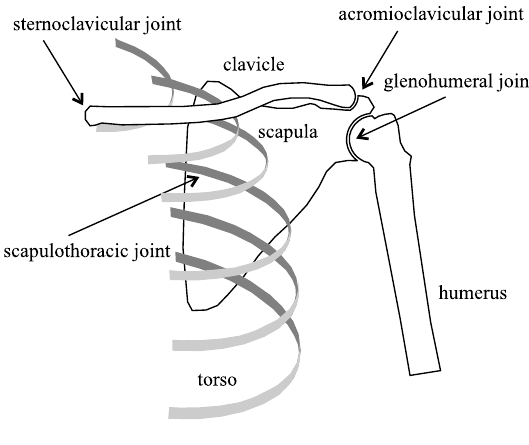
Fig. 1. The Human Shoulder Girdle